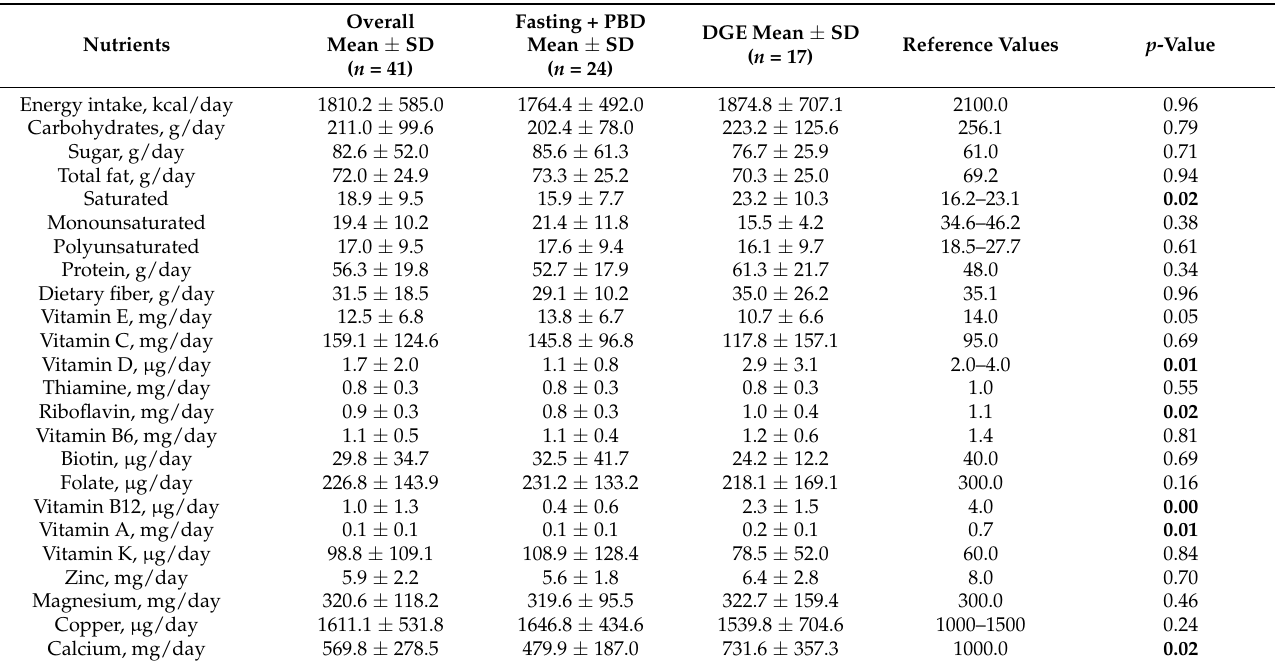
Table 3. Nutrient supply of participants with RA at study week 9 as well as the DGE reference values for adult women